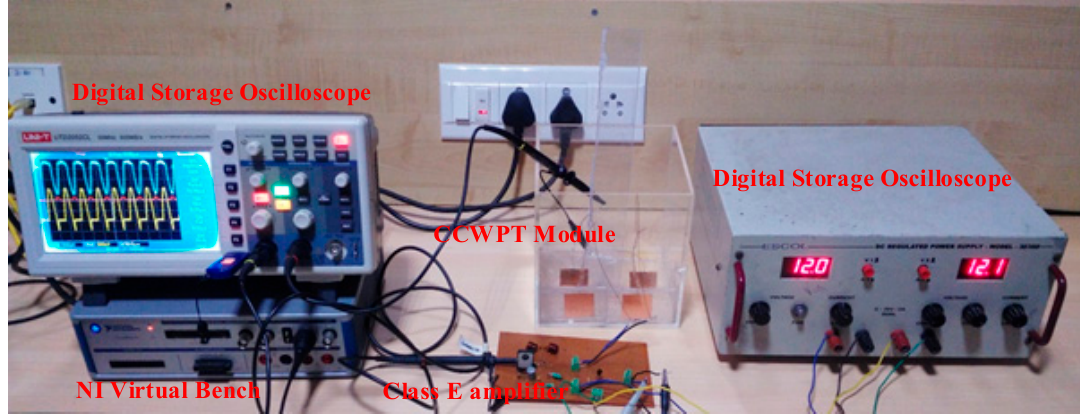
Figure 18. Experimental Setup of Class E PA with CCWPT.